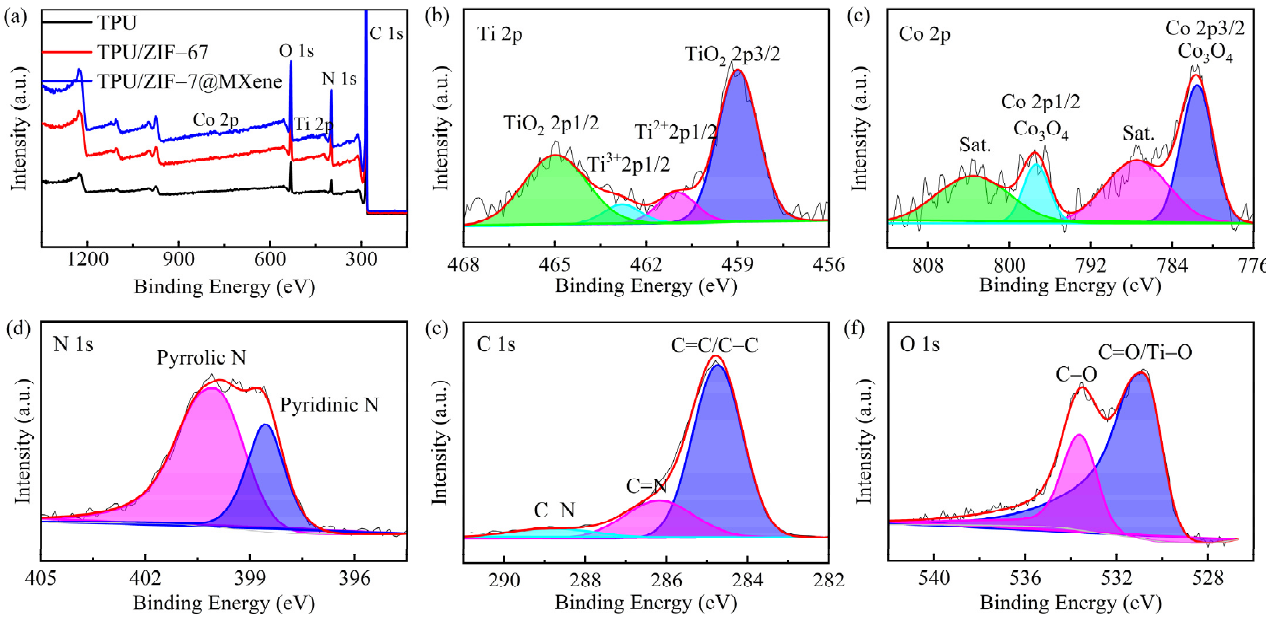
Figure 10. ( a ) XPS survey spectra of the residues of TPU composites; the high-resolution ( b ) Ti 2p, ( c ) Co 2p, ( d ) N 1s, ( e ) C 1s, and ( f ) O1s XPS spectra of the residues of TPU/ZIF-67@MXene